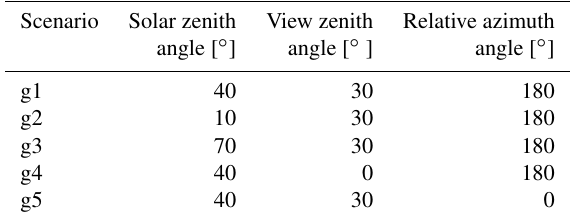
Table 2. Observation geometry scenarios for BAMF and AMF cal- culations with different aerosol and cloud